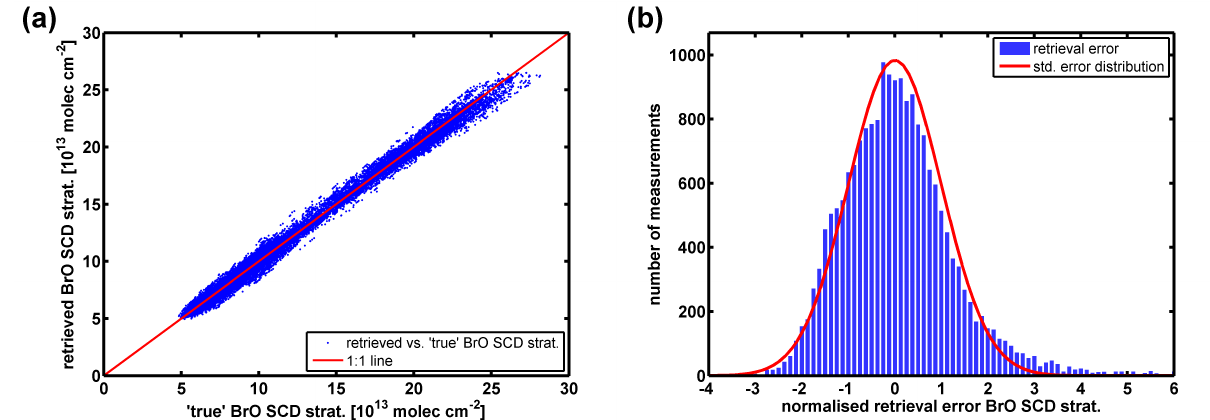
Fig. 10. Benchmark results of the column separation algorithm using an ensemble ( n = 20000) of concentration profiles of BrO, O 3 , and NO 2 simulated by the EMAC model. (a) Retrieved stratospheric BrO SCDs against “true” input BrO SCD. (b) Distribution of the difference 1 between retrieved and input BrO SCD normalised by the BrO standard deviation σ strat as provided by the retrieval (see text).